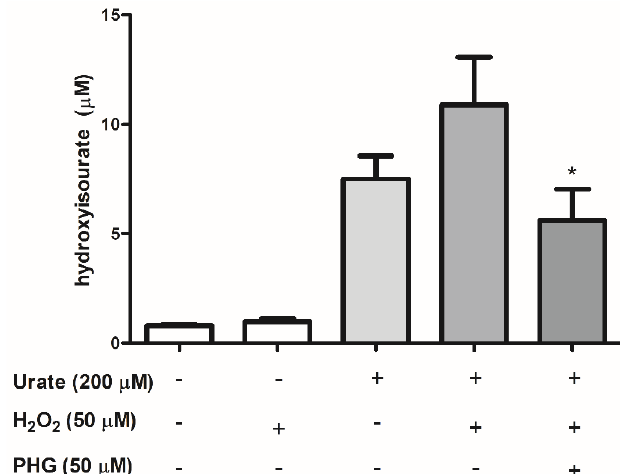
Figure 4. Oxidation of urate by PXDN produces 5-hydroxyisourate. HUVEC secretome was concentrated and incubated with 200 µM urate in the absence or presence of 50 µM H 2 O 2 and 50 µM PHG in 50 mM phosphate buffer, pH 7.4 for 30 min at 37 °C. After incubation, samples were suspended in 2% trichloroacetic acid (TCA) and 60% acetonitrile (ACN), centrifuged and the supernatant was injected onto LC/MS/MS. Each datum represents the mean ± S.E.M. (n = 3). Statistical analyses were performed by one-way ANOVA followed by Bonferroni’s post-test, * p < 0.05 compared to the control group. PHG: phloroglucinol.